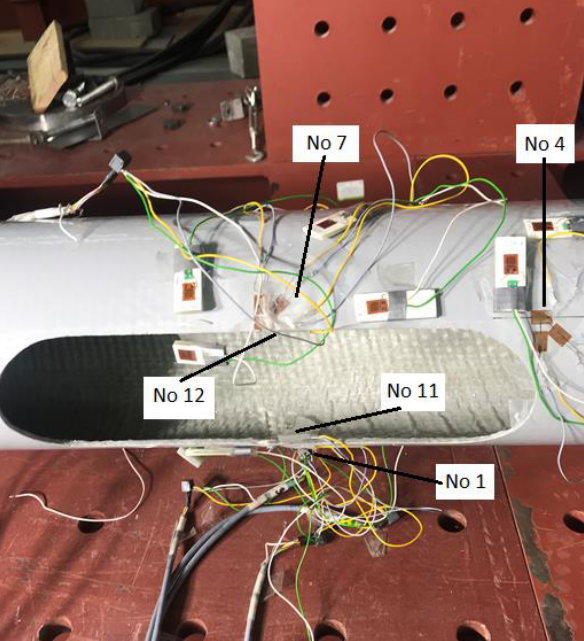
Figure 4. Locations of individual strain gauges.